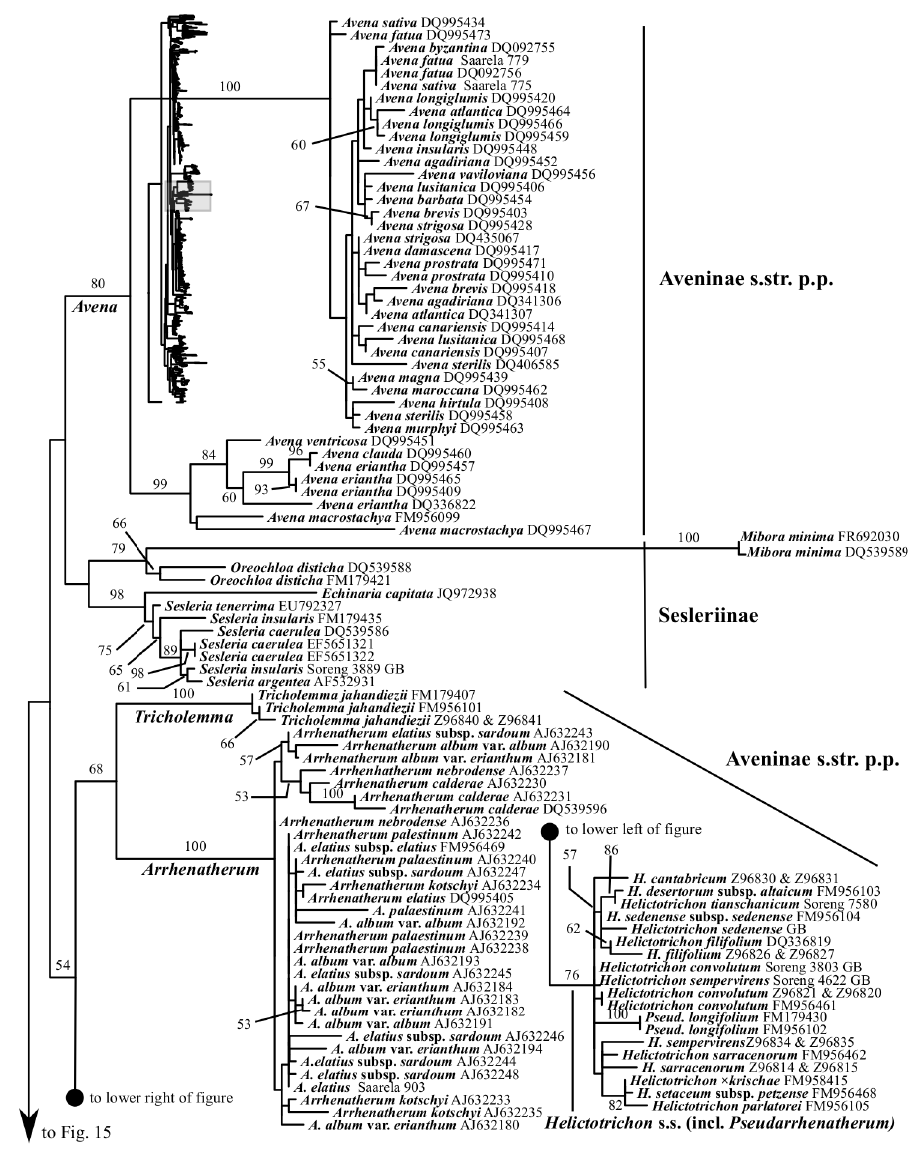
Figure 14. A portion (Aveninae s.str., Sesleriinae) of the maximum likelihood phylogram inferred from ITS data. ML bootstrap support is recorded along branches when >50%. The shaded area of the smaller tree on the upper left indicates the location in the overall tree of the portion shown.